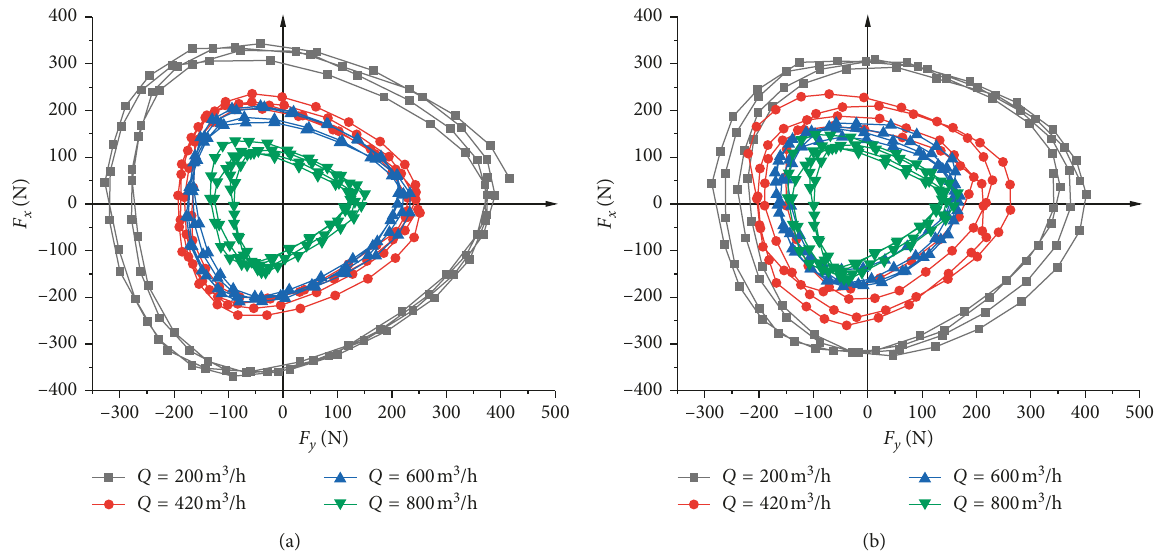
Figure 16: Radial force vector diagram in the (a) first-stage impeller and (b) second-stage